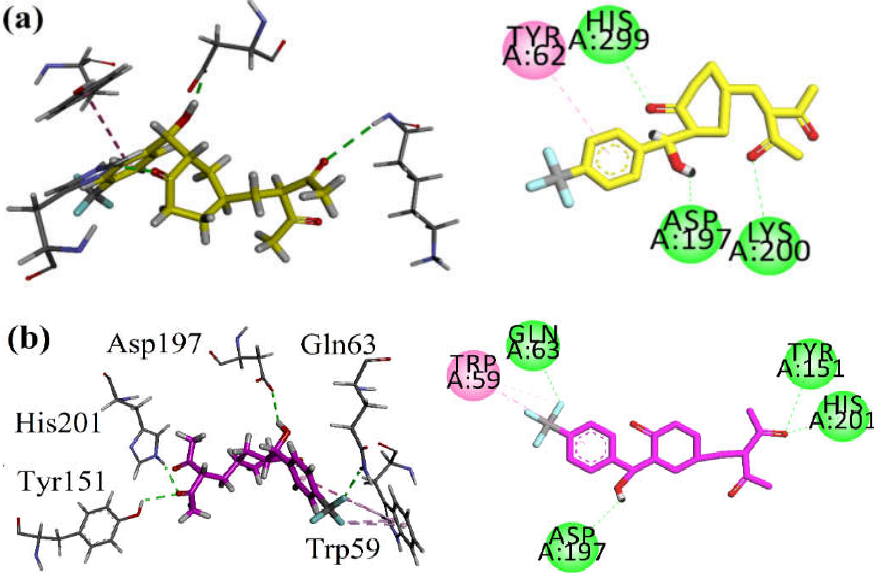
Figure 2. 3-D/2-D interaction plot of ( a ) major ( S , S , R - 5 , as yellow stick model) and; ( b ) minor ( S , S , R - 5 , as pink stick model) diastereoisomers into the binding site of homology modeled α-glucosidase.